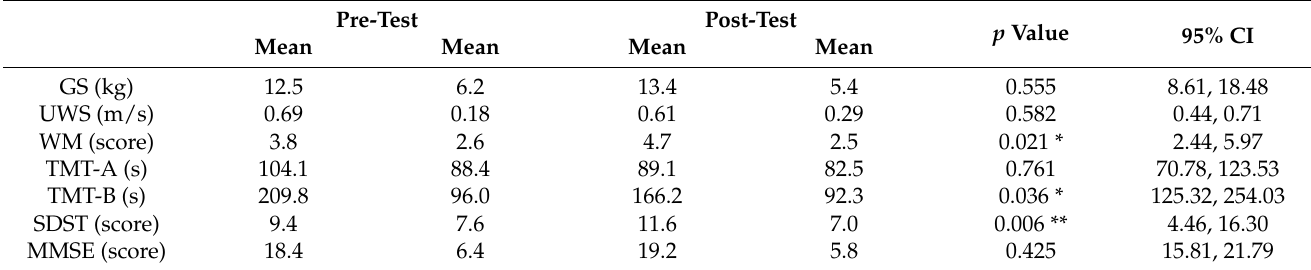
Table 2. Result of pre-test and post-test in the